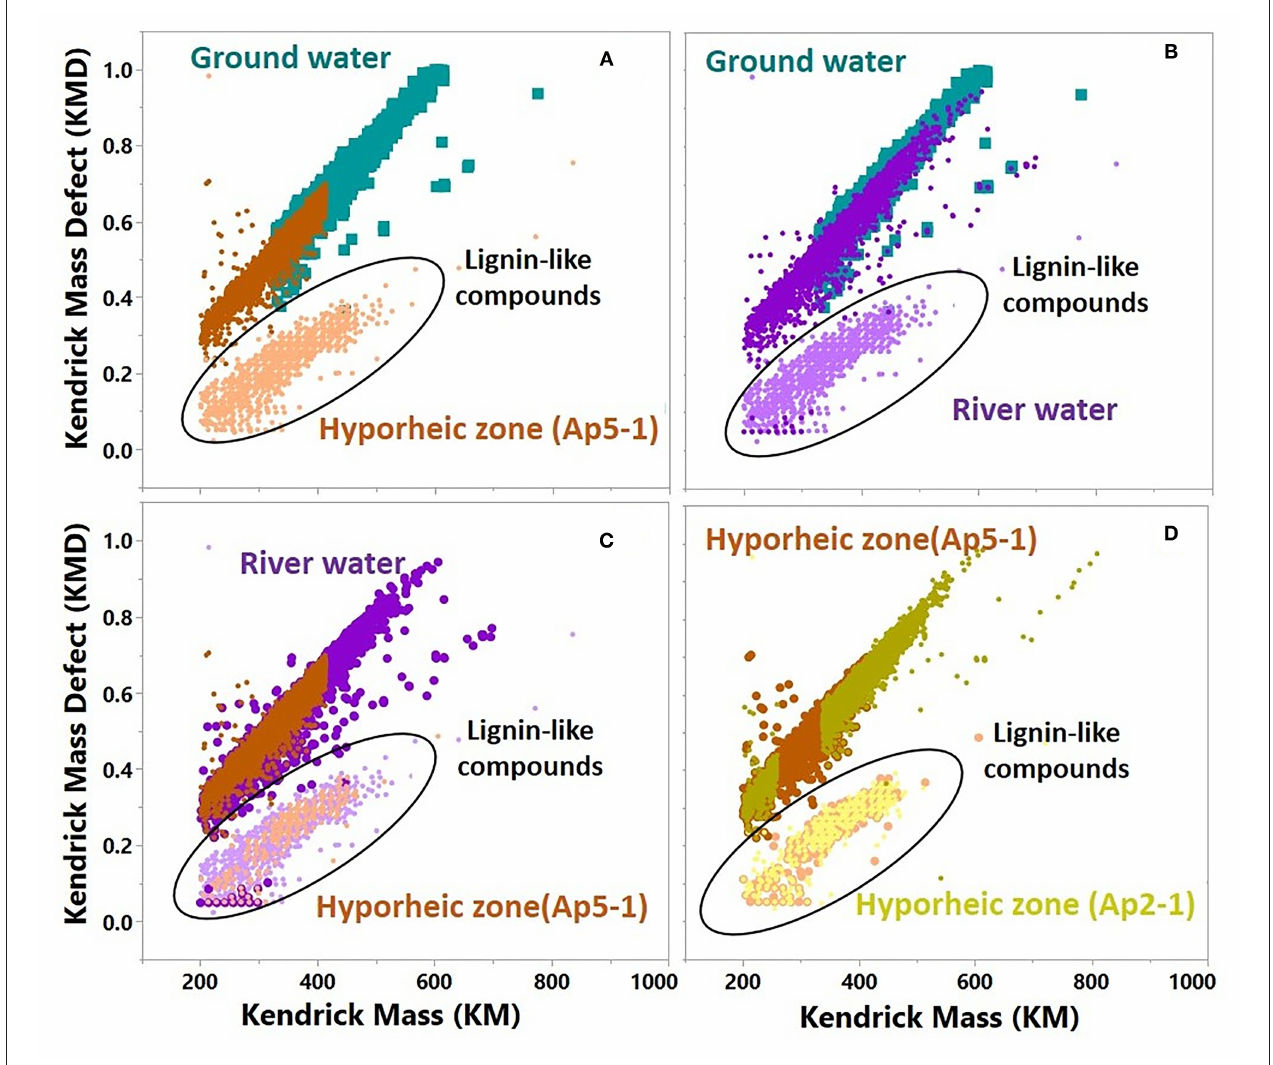
FIGURE 8 | Kendrick plot comparison of molecular formulas that were used in network analysis for representative samples from time interval A. (A) Ground water vs. Hyporheic zone (AP5-1); (B) Ground water vs. River water; (C) River water vs. Hyporheic zone (AP5-1); (D) Hyporheic zone (AP5-1) vs. Hyporheic zone (AP2-1), For river water and Hyporheic zone samples, peaks that were part of the small network (represented by the black empty circle) from subpanel A were identified as lignin-like compounds and were colored with a lighter color than peaks that were part of the big network from subpanel